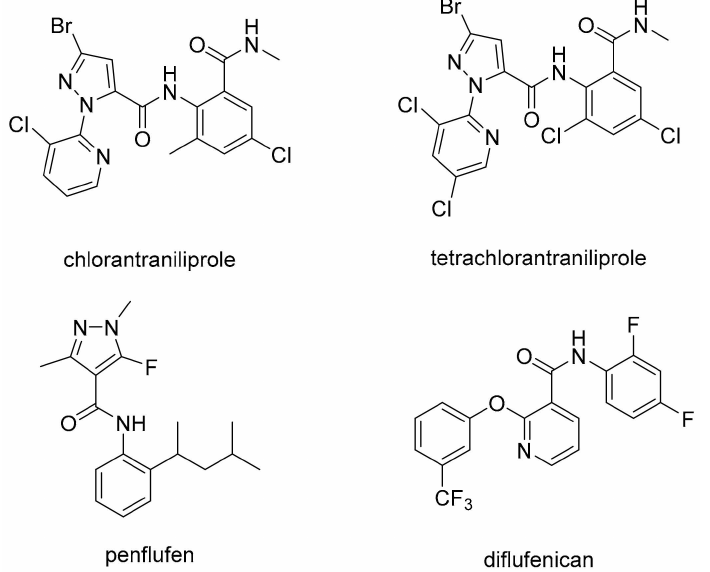
Figure 2. Structures of the reported amide-based